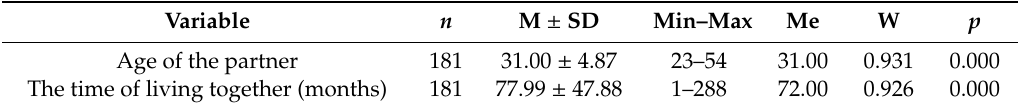
Table 4. The mean age of the husband / partner.